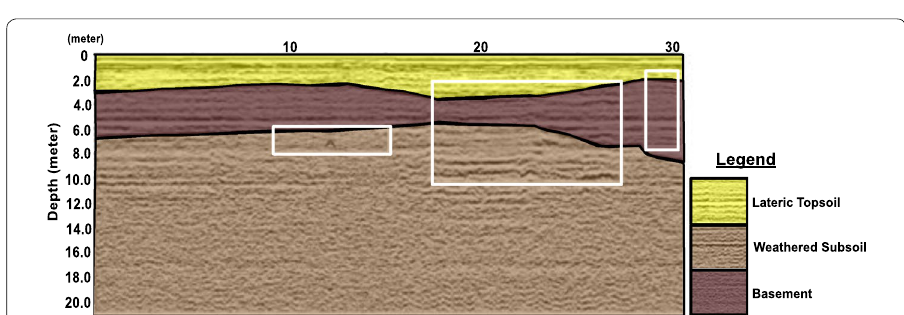
Fig. 26 GPR profile 4 overlaid on Geo-electric section traverse 4